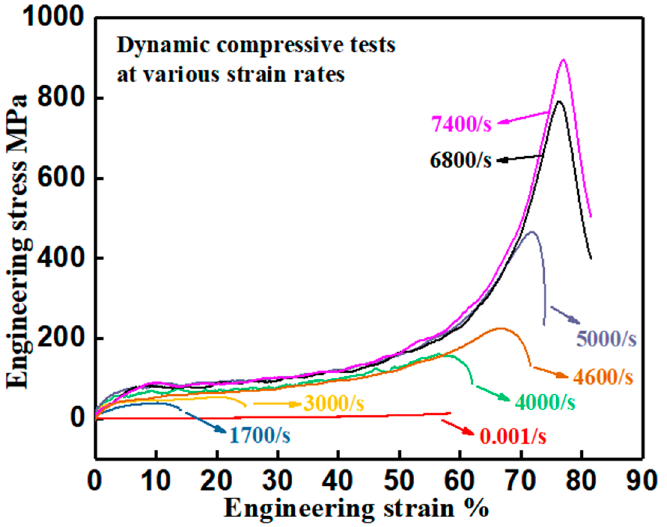
Figure 5. Representative dynamic compressive engineering stress–strain curves of the developed PUE material at various strain rates.